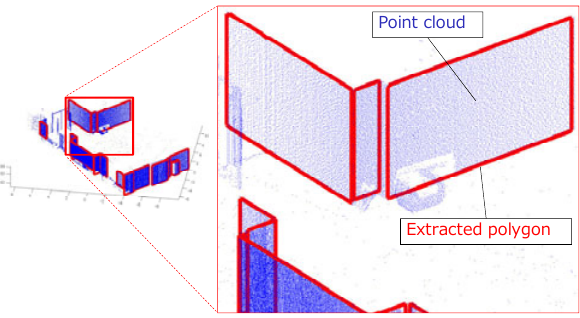
Figure 12. Point cloud and polygon extraction result